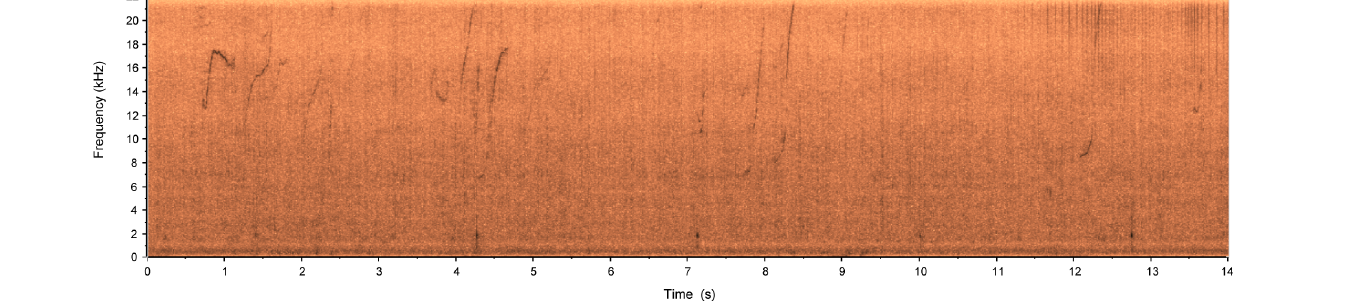
Fig 11. Spectrogram of estuarine dolphin vocalizations registered at Sepetiba Bay, RJ, Brazil.